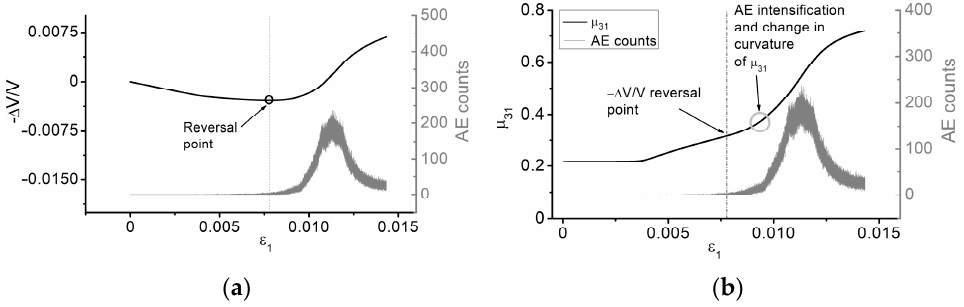
Figure 10. Curves of dependence combined with AE increment: ( a ) volumetric strain, ( b ) instanta- neous Poisson’s ratio.